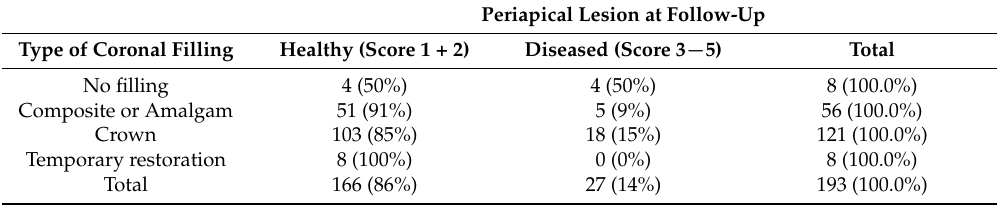
Table 5. Relationship between the type of coronal filling and the periapical lesion (PAI) at follow-up.